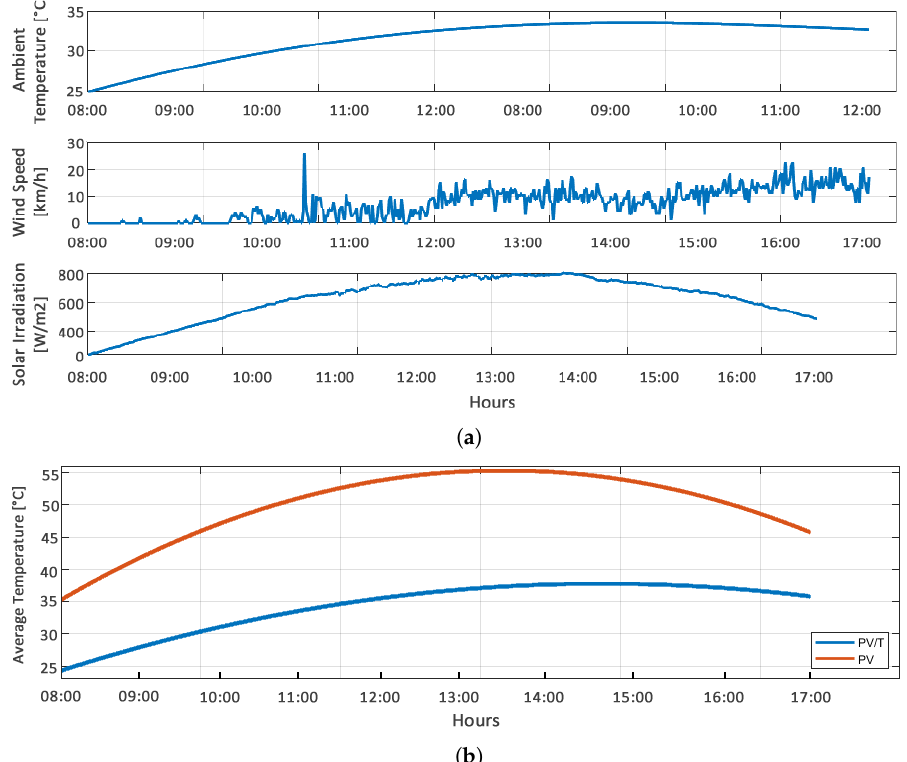
Figure 6. Logged weather data on 23 June 2021 ( a ) and simultaneous temperature changes of PV and PV/T modules ( b